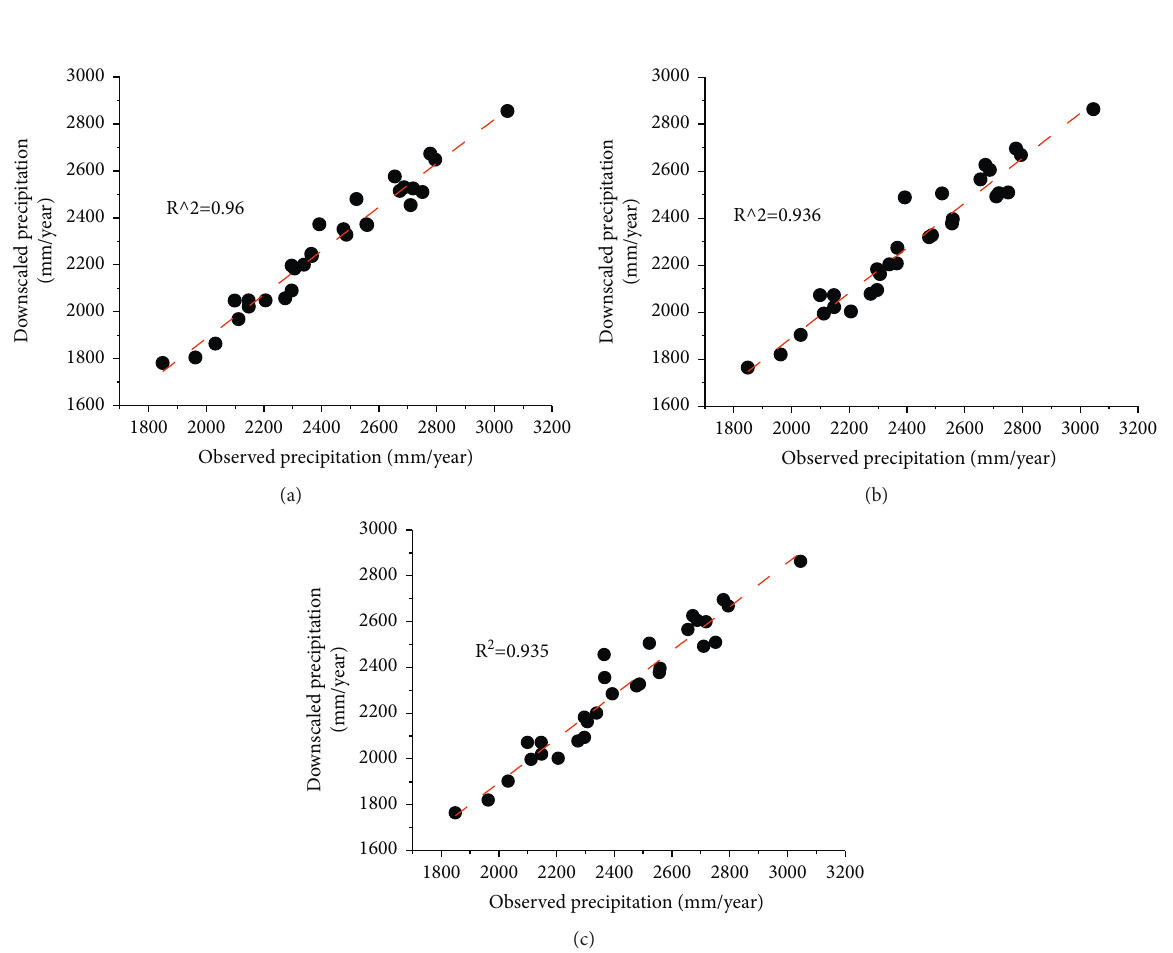
Figure 4: The correlation between downscaled precipitation by (a) GBR, (b) RF, (c) SVM and observed precipitation, respectively.